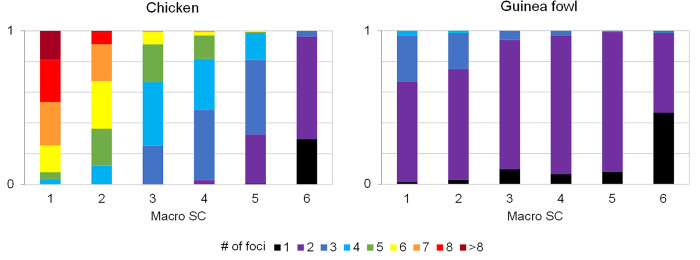
Comparative distribution of MLH1 foci in the six largest macrobivalents.Each column represents the distribution of SCs with n foci as a fraction of the cells analyzed in each species. Colors indicate bivalents with 1 to 8 or >8 foci. The color code is shown below the graph.